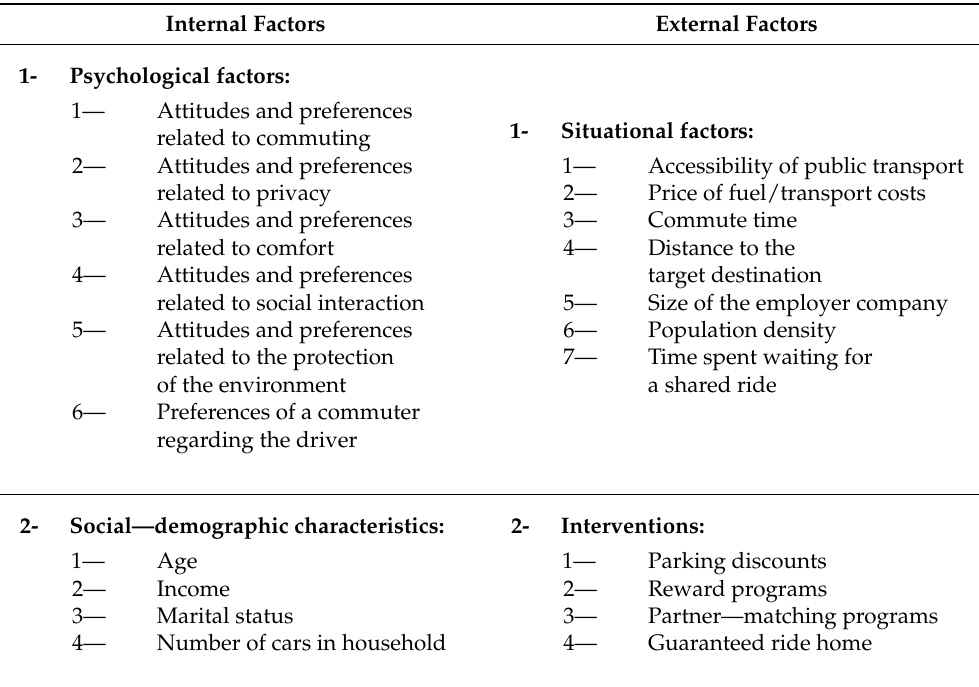
Table 1. Factors influencing the decision making process regarding VOT